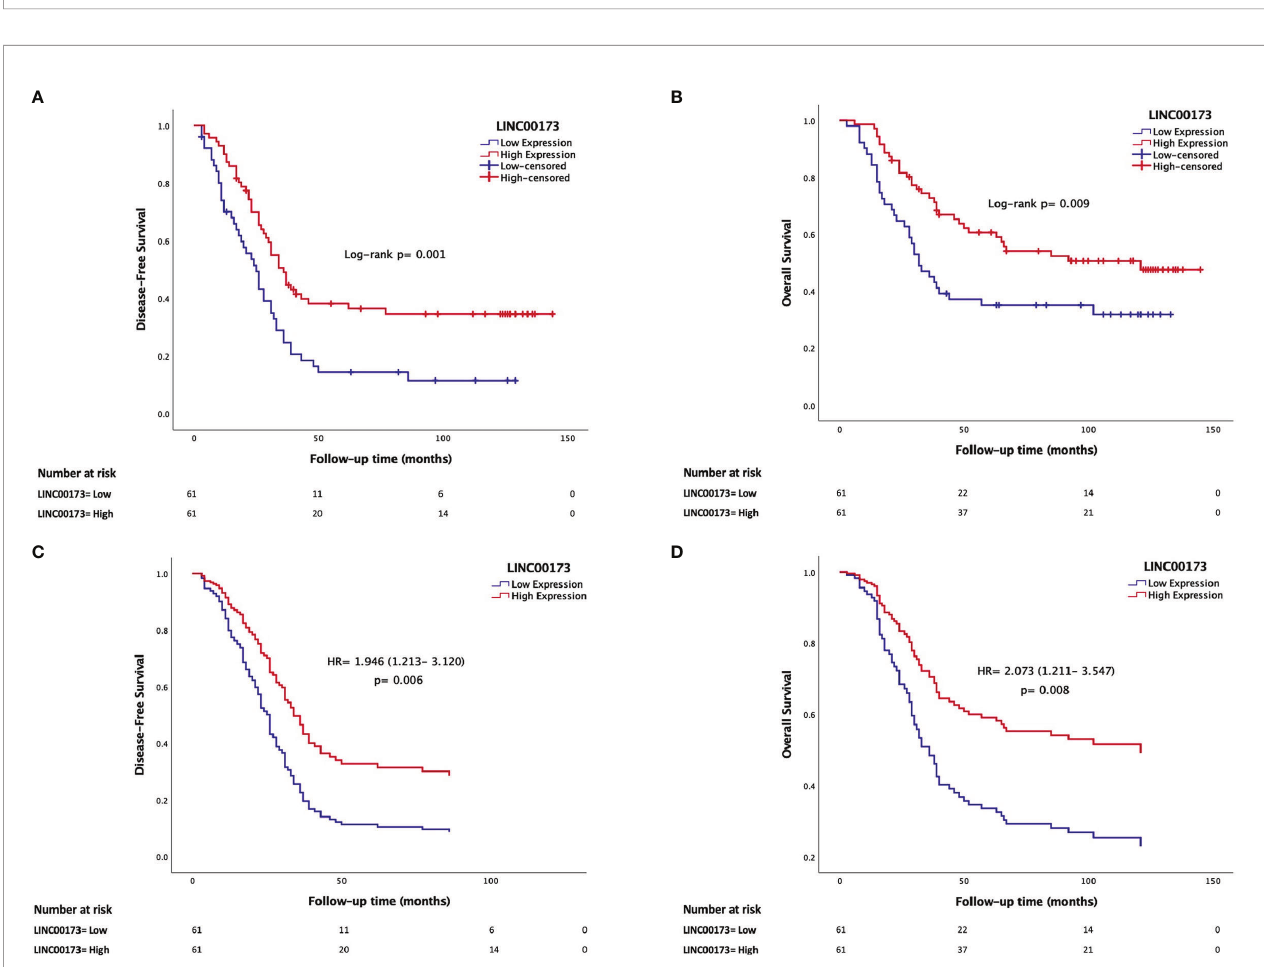
FIGURE 3 | LINC00173 expression in B-cell precursor acute lymphoblastic leukemia patients with relapse or death from the TARGET cohort. (A) Patients with relapse versus no-relapse. (B) Patients with death versus alive at least 18 months after fi rst remission. * p <